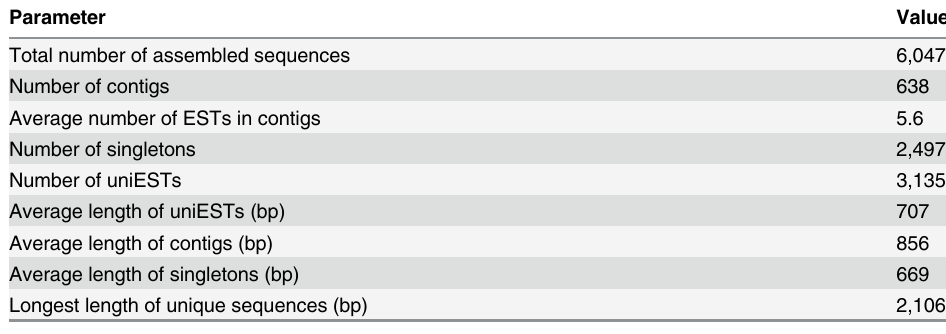
Table 1. EST sequence and assembly statistics.